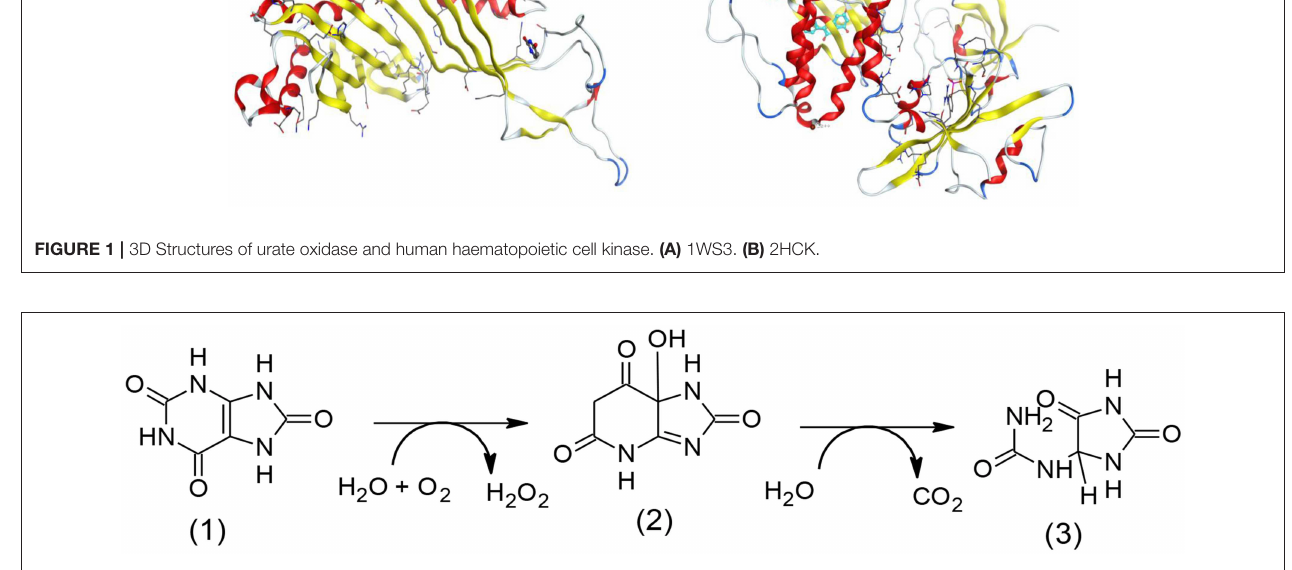
SCHEME 2 | Graphic degradation pathway of uric acid (1) to allantoin (3) through (2)